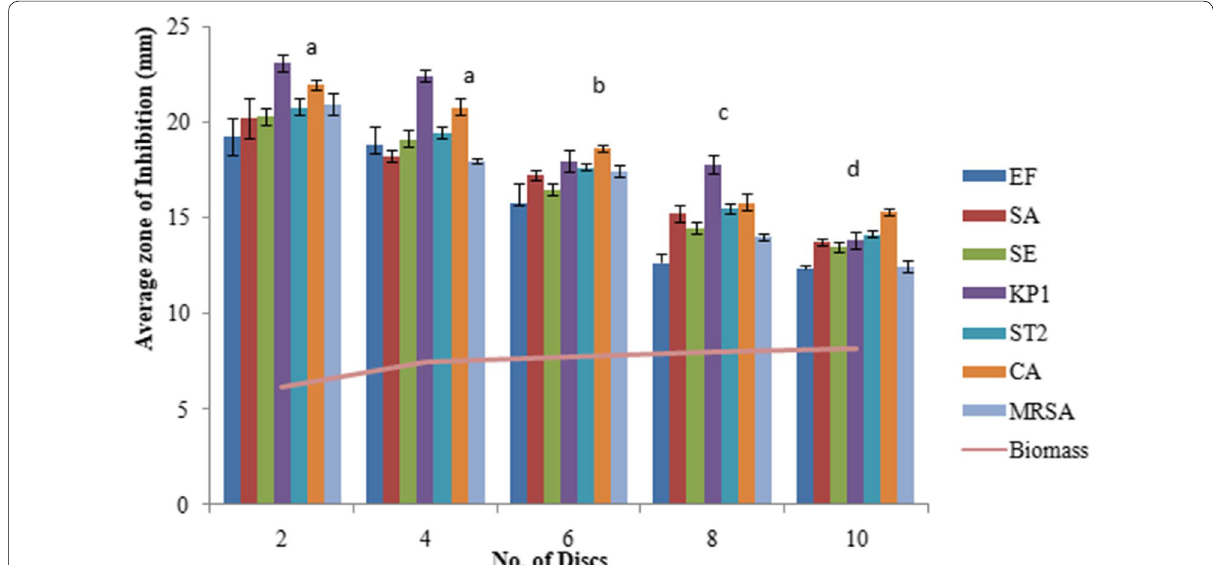
Fig. 1 Effect of inoculum size on antimicrobial activity of C. globosum . EF, Enterococcus faecalis; SA, Staphylococcus aureus ; SE, Staphylococcus epidermidis ; KP1, Klebsiella pneumoniae 1; ST2, Salmonella typhimurium 2; CA, Candida albicans MRSA, Methicillin-resistant Staphylococcus aureus . *Values are given as mean SE. Different letters (a to d) between the columns are significantly different (post hoc tukey Test, p ±